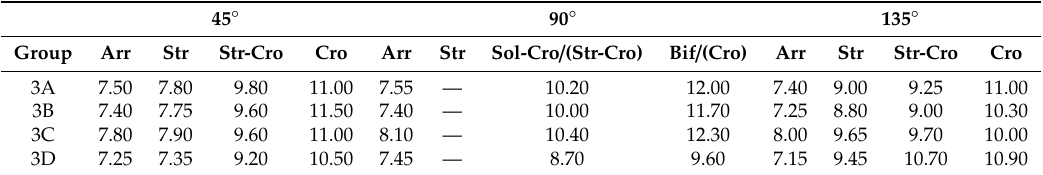
Table 7. Fluid pressure values corresponding to di ff erent in situ stress ratios.